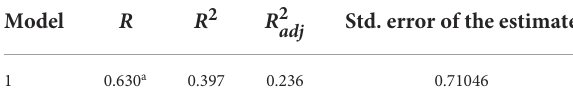
TABLE 9 Fitted model (I).